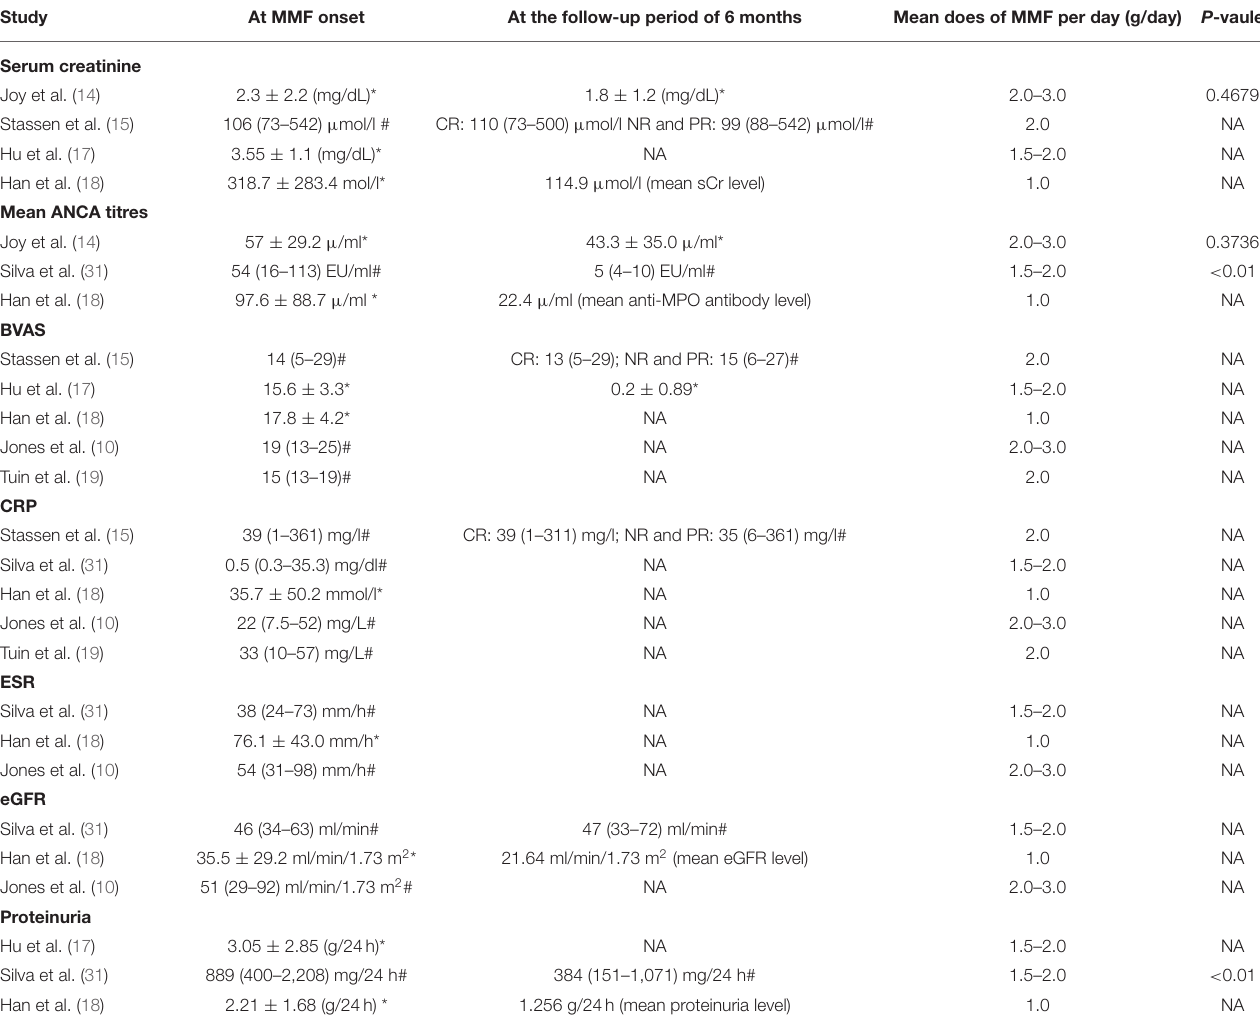
TABLE 2 | Clinical and laboratory parameters in patients undergoing MMF treatment in the included studies. Study At MMF onset At the follow-up period of 6 months Mean does of MMF per day (g/day) P -vaule Serum